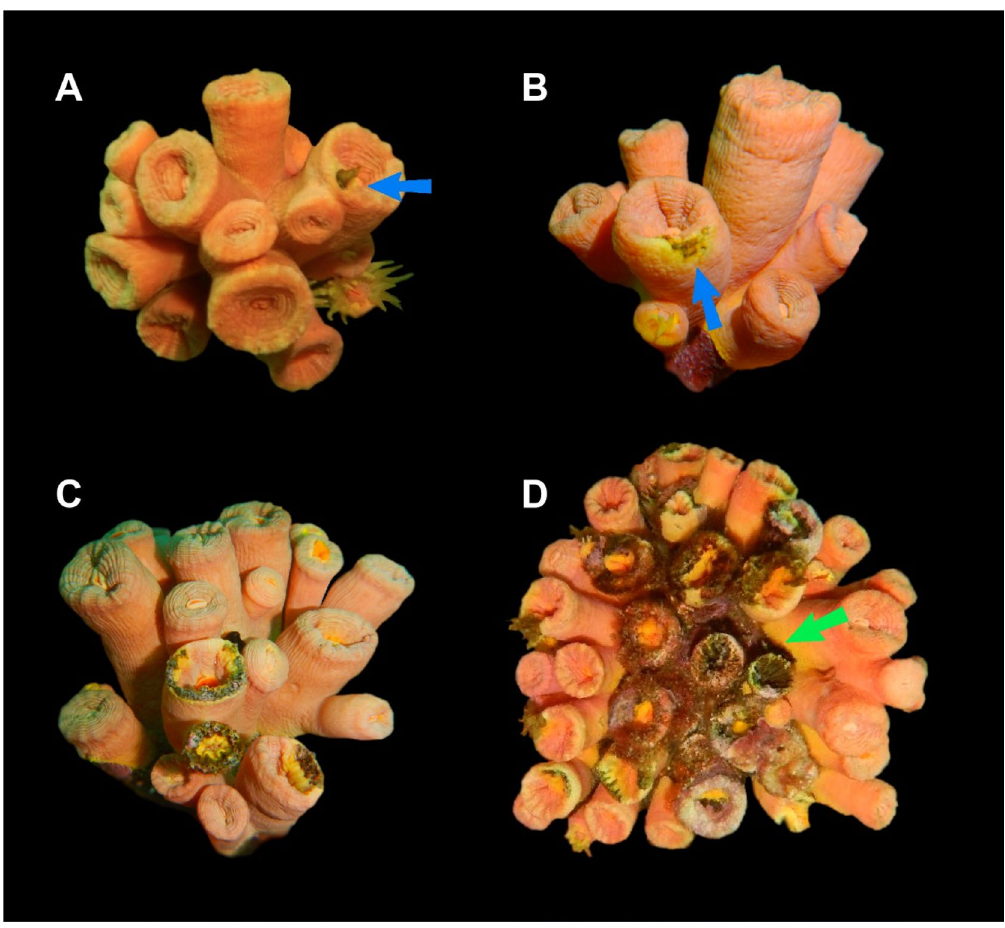
Figure 1. Tubastraea tagusensis colonies from Búzios Island—SP, showing signs of tissue necrosis. ( A ) and ( B )—the early stage of tissue necrosis, with a single polyp displaying only a small brown dot (blue arrows). ( C )— tissue necrosis progressing throughout the polyp (intermediate stage). ( D )—Tissue necrosis at an advanced stage with polyps taken over by the disease (green